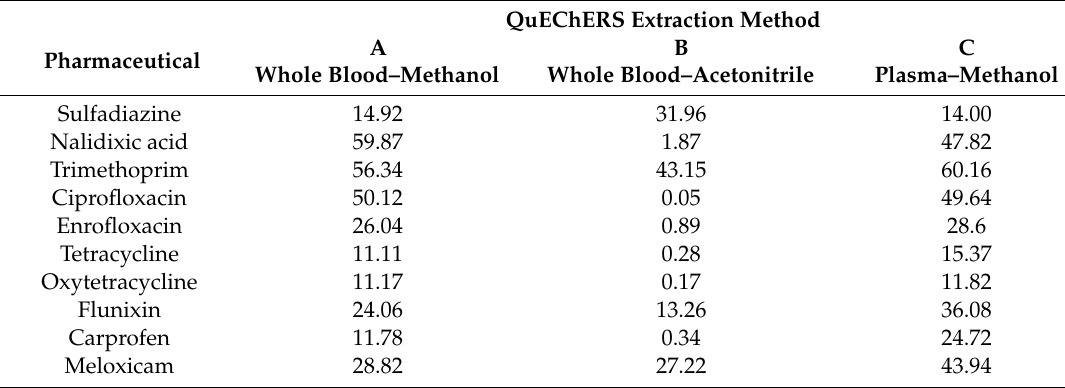
Table 2. Recoveries (%) obtained by the QuEChERS (Quick, Easy, Cheap, E ff ective, Rugged, and Safe) methods A, B and C at 100 ng mL − 1 .